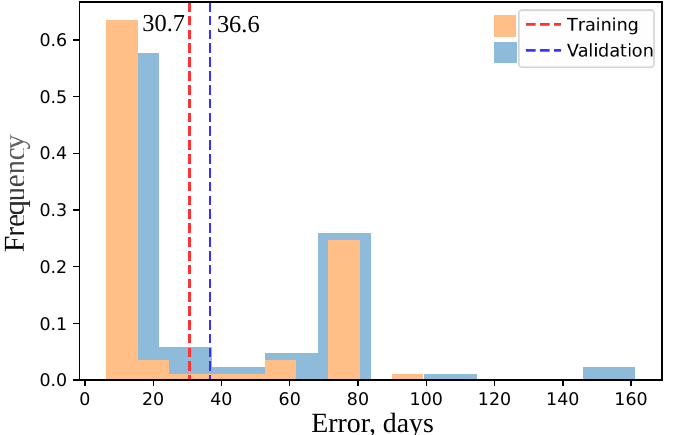
Figure 3. The histograms of the root mean sum of squared differences between the model solution and data in terms of the number of days from sowing to flowering for the training and validation sets. Vertical lines correspond to the